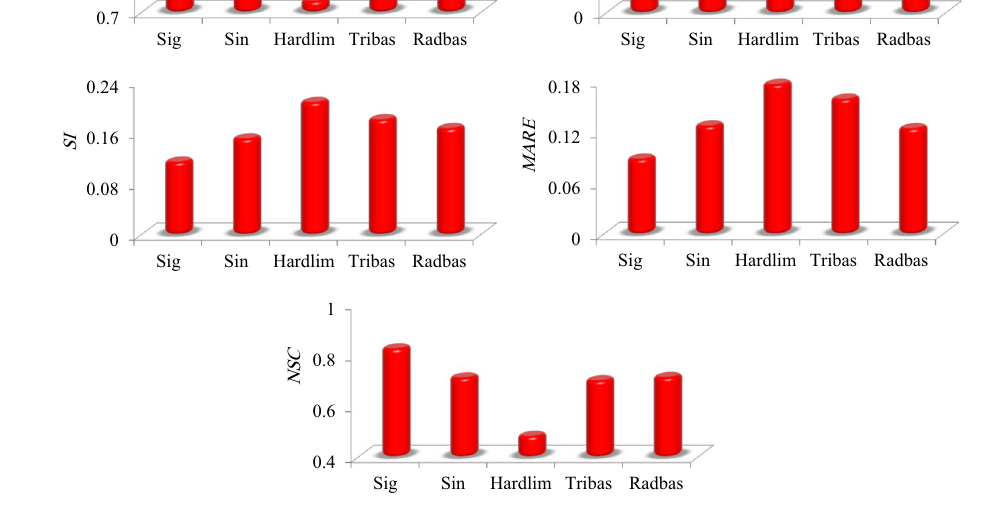
Fig. 6 Results of statistical indices calculated for different activation functions